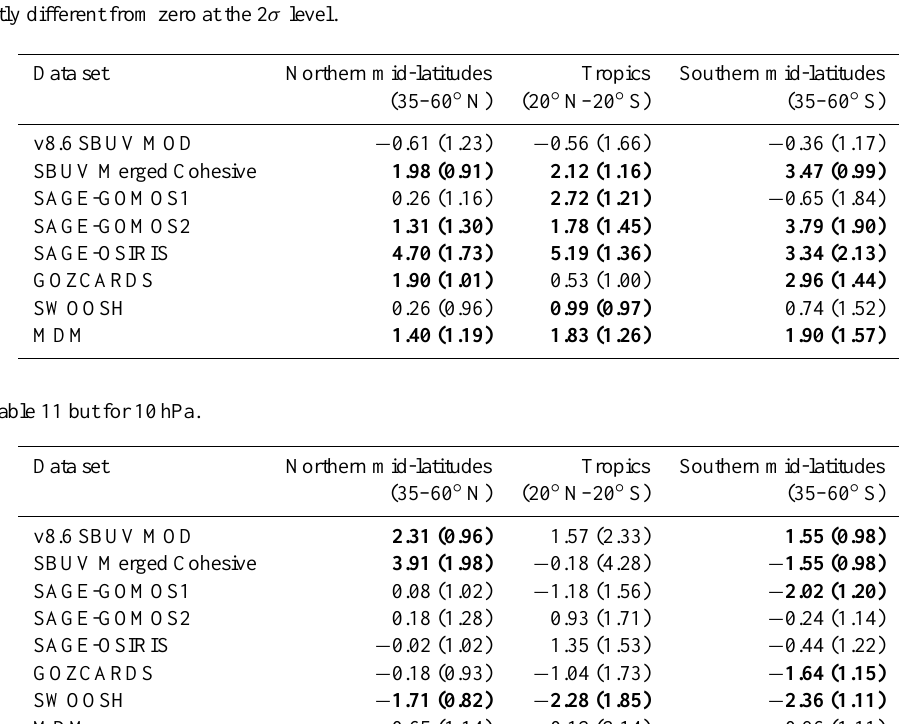
Table 11. Trends in %decade − 1 for the 1998–2011 period at 2hPa. Values in brackets show the 2 σ uncertainty estimates, while those in bold are significantly different from zero at the 2 σ level.